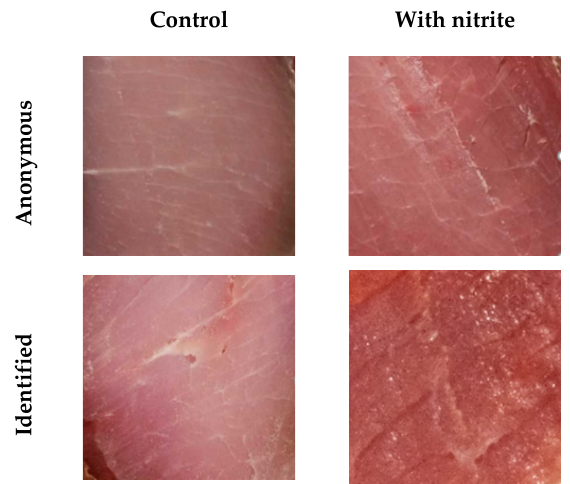
Figure 1. Images of cured loins presented in the online consumer test. Anonymous—no information was provided to the consumer; identified—samples were identified with the information “Cured Loin 1 has a food additive indicated by the WHO as being carcinogenic; Cured Loin 2 does not have any chemical additives”.